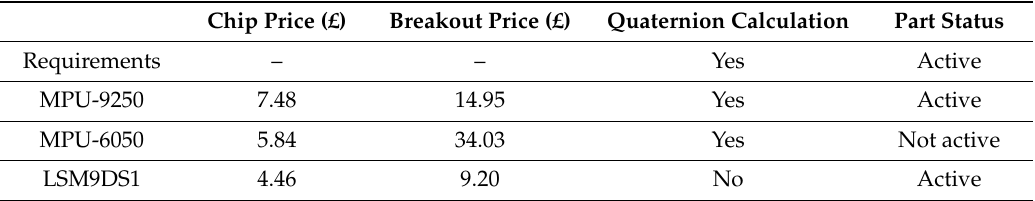
Table 4. Comparison of inertial measurement units [28–33].